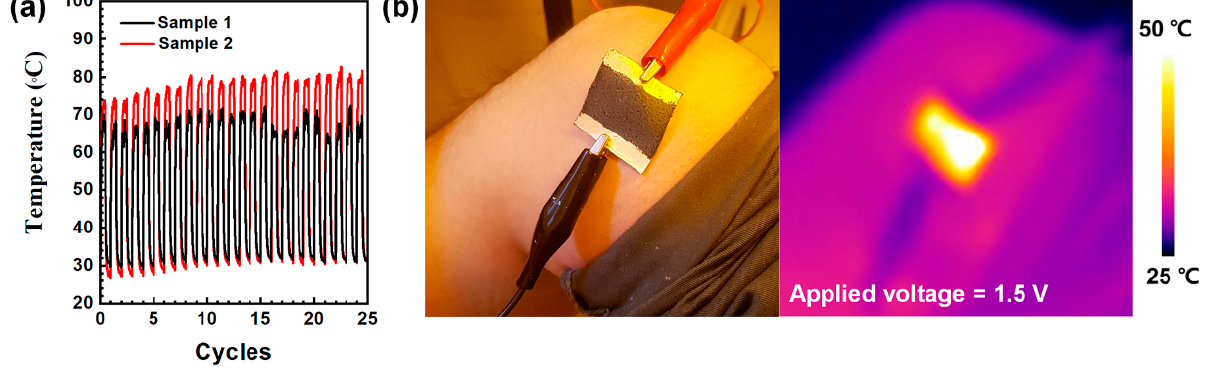
Figure 8. ( a ) Cyclic test of Joule heating properties of the E-textiles under a bias of 1.5 V and ( b ) the thermal patch application of sample 2 at the knee.